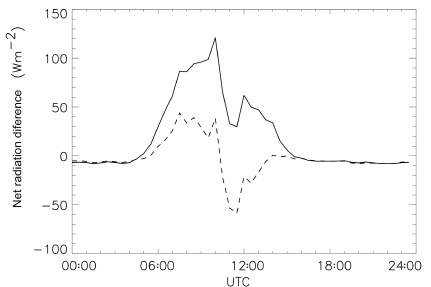
Figure 9. Comparison of the differences in net radiation. WET mi- nus VWET net radiation is the solid line, and DWET minus VWET net radiation is the dashed